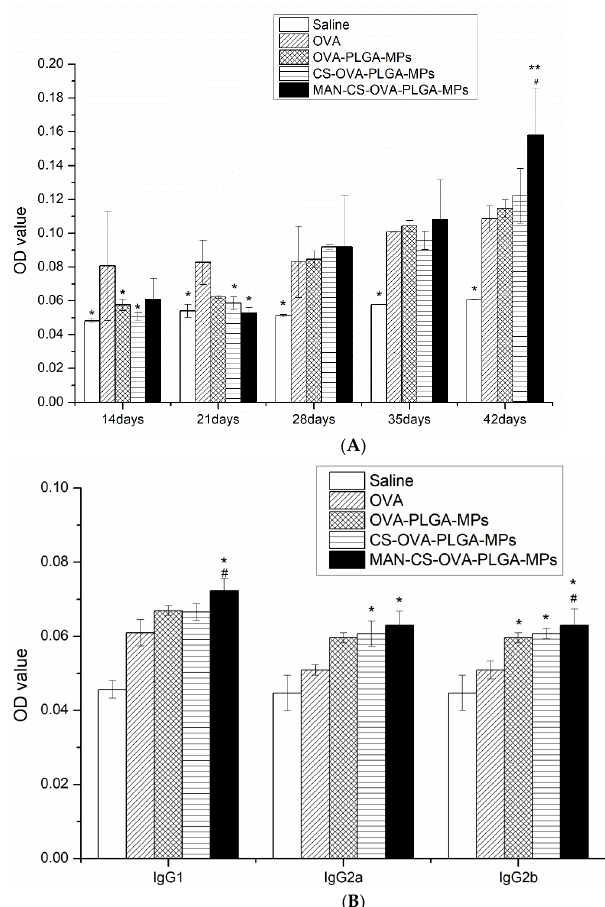
Figure 7. Effect of the MAN-CS-OVA-PLGA-MPs on OVA-specific IgG and IgG subtypes in serum of mice. Serum samples were collected for ELISA from immunized ICR mice in all groups between 14–42 days following the first immunization. The OVA-specific IgG (A) and IgG isotype (IgG2a, IgG2b, and IgG1) serum levels were determined by ELISA as described in Section 2. The concentrations of IgG and IgG isotopes are presented as mean ± standard deviation. * p < 0.05, ** p < 0.01 compared with OVA; # p < 0.05, ## p < 0.05 compared with CS-OVA-PLGA-MPs. Results are presented as the mean ± SD ( n = 3).